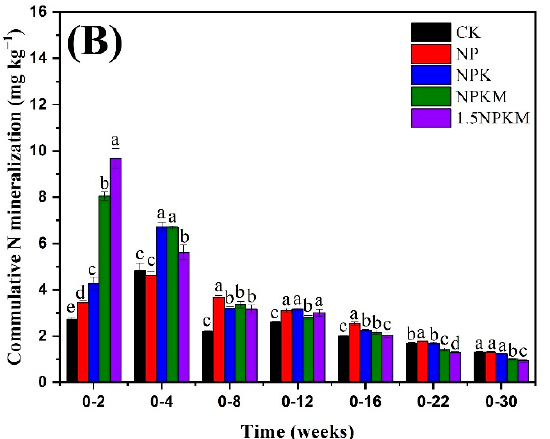
during the same period according to Duncan’s test.